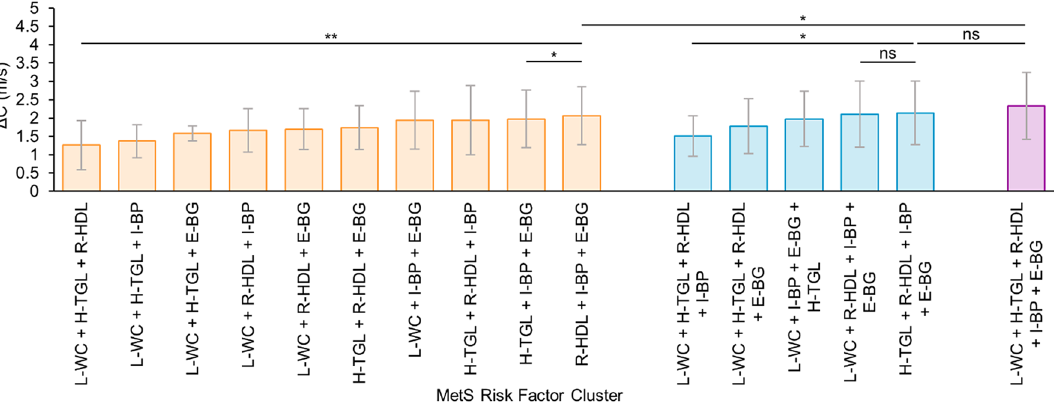
Figure 3. Clustering effect of multiple (3, 4, and 5) risk factors on ΔC across MetS group (N = 455) (ns p > 0.05, * p ≤ 0.05, ** p ≤ 0.001).